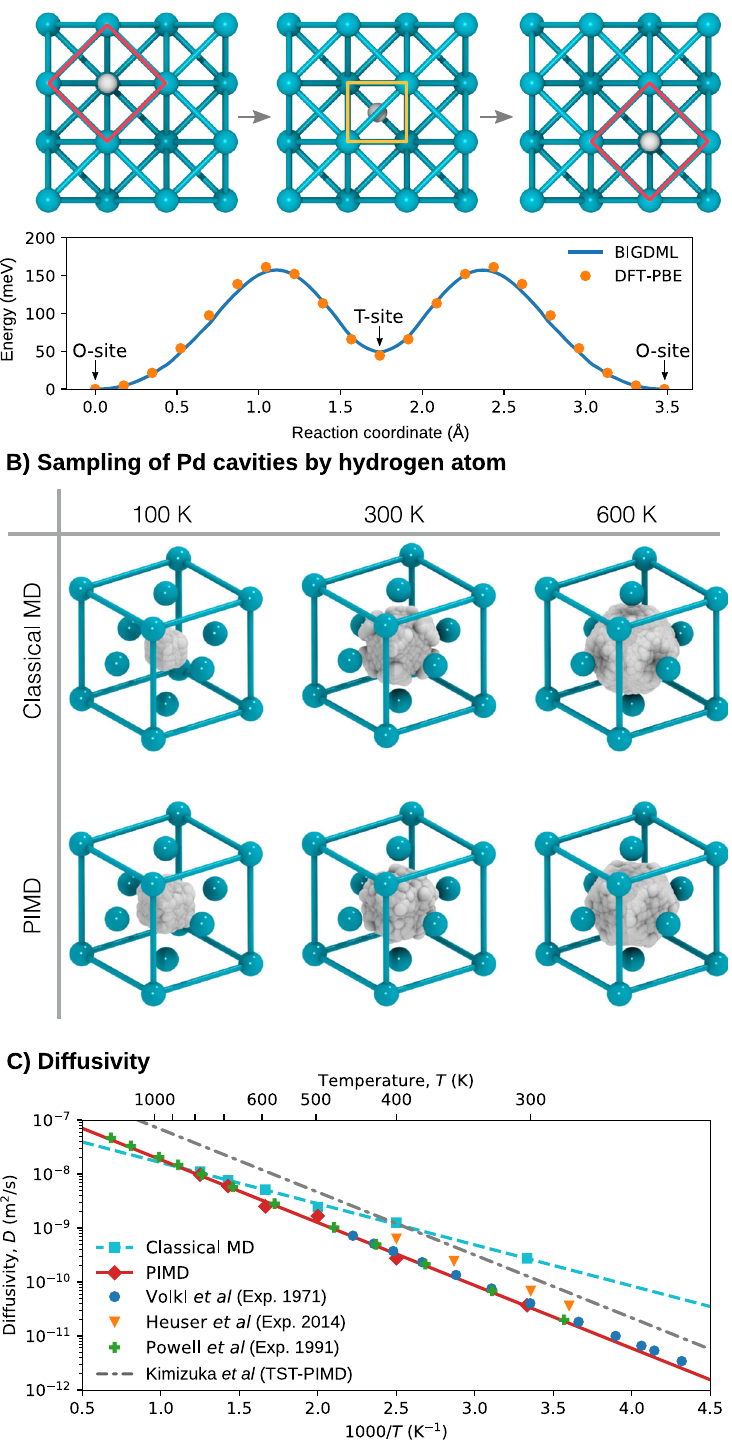
Fig. 9 Interstitial hydrogen diffusivity in bulk Pd. A (Top) Minima of the trajectory used to calculate the minimum-energy path (MEP) for the diffusion of H in FCC Pd. (Bottom) MEP as calculated using BIGDML (continuous line) and DFT-PBE (circles) between adjacent O- and T-sites. B Three-dimensional plots of the probability distribution of the H atom in the O-site at different temperatures. C Diffusivity of H in bulk Pd as a function of the temperature. The cyan squares and red diamonds represent the values calculated running classical MD and PIMD using the BIGDML model, respectively. The lines are the Arrhenius fi t to the data from MD@BIGDML (cyan, dashed), PIMD@BIGDML (red, solid) and TST-PIMD by Kimizuka et al. (gray, dash-dotted) 98 . Experimental data were taken from refs. 117 (blue circles) 118 , (orange triangles) and 119 (green